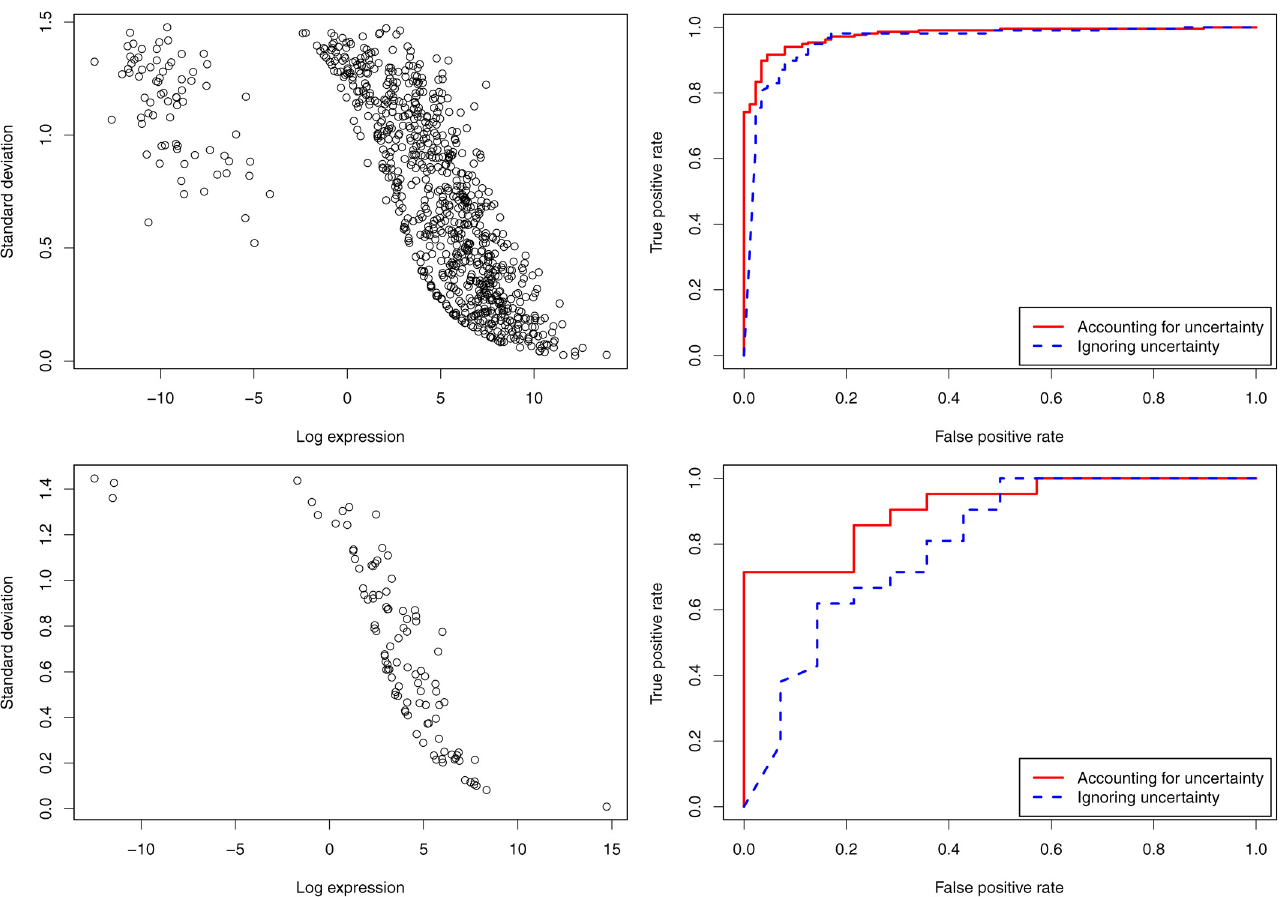
Fig 5. Usefulness of measurement error obtained by PGseq. The scatter plots (left column) show the standard deviation vs. the logarithm of gene expression for the PCR-validated genes in the MAQC (upper panel) and HCC (lower panel) datasets. As the expression level increases the associated measurement error decreases. The ROC curves (right column) indicate the difference between accounting for and ignoring measurement uncertainty in the DE analysis. The DE analysis employs MMDiff which considers expression measurement error. The solid curves show the performance of the DE analysis considering expression measurement error, and the dashed lines ignore measurement error by setting zero measurement